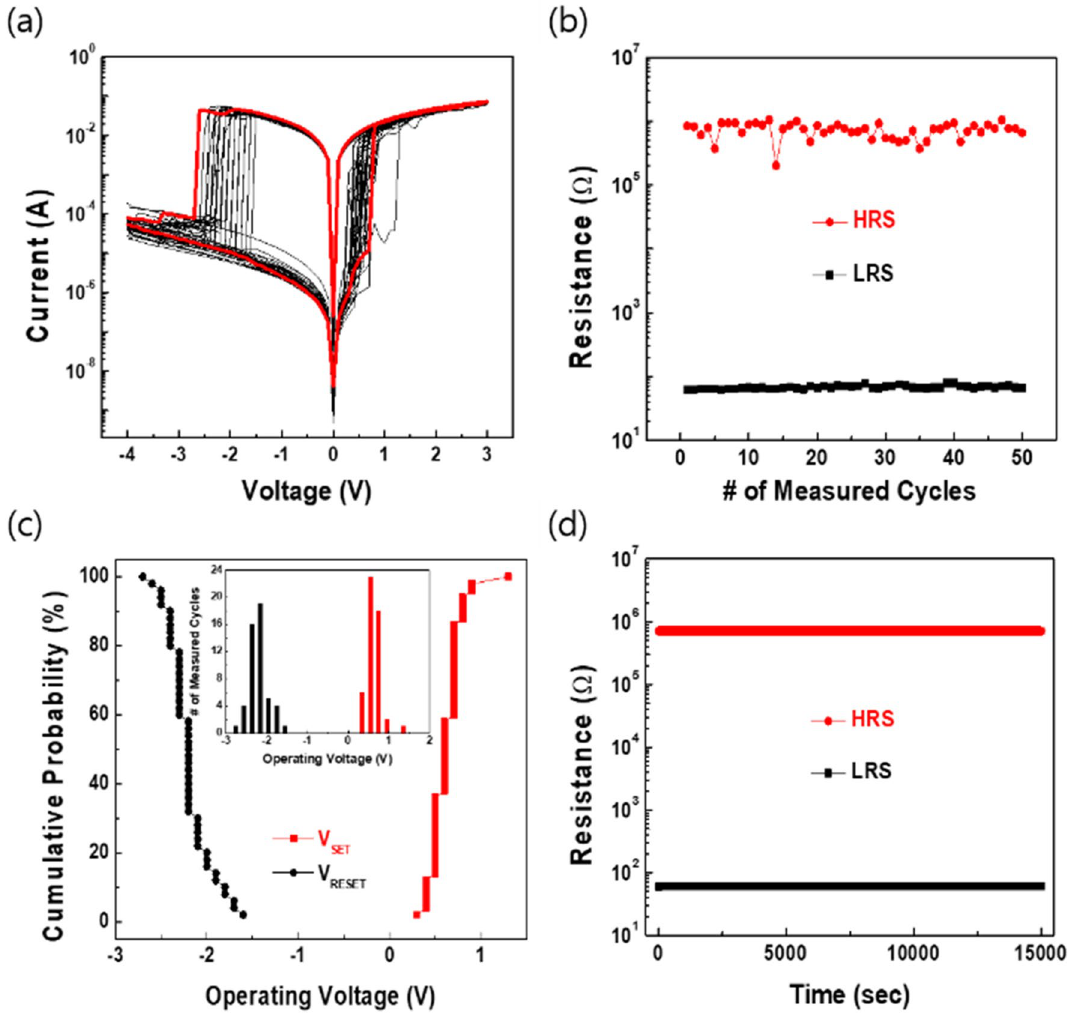
Figure 3. ( a ) Current–voltage curves on a semi-logarithmic scale for the Al/zein/ITO device for 50 cycles. The thick red line shows the result after the first sweep. ( b ) Endurance performance in the DC sweep mode for 50 cycles. ( c ) Cumulative probabilities for the SET and the RESET voltages in the DC sweep mode. ( d ) Retention test result over 10 4 s at 295